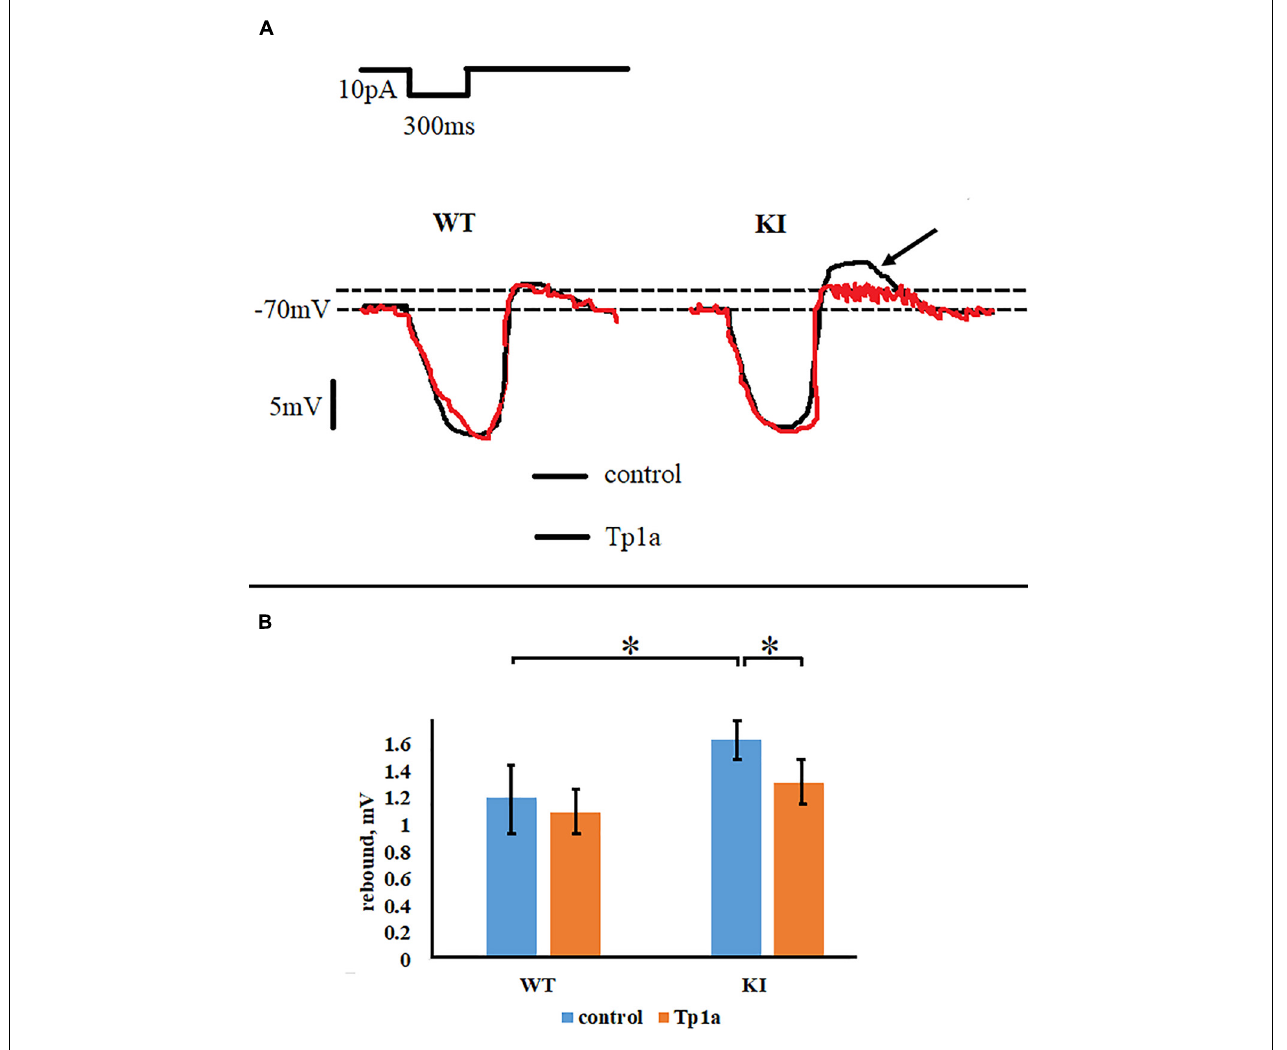
FIGURE 6 | Tp1a reduces rebound effect after a 300-ms hyperpolarizing pulse of 10 pA in R192Q KI TG neurons. (A) Representative responses of WT and R192Q KI neurons, recorded in control and after application of Tp1a (7 nM, 30 min). Arrow shows higher rebound in KI which is reduced by Tp1a. (B) Histograms represent rebound effect in WT and KI neurons under control conditions and after 30 min application of 7 nM Tp1a. *Indicates statistically significant change (two-sample Student’s t -test, p -values are given in the text body). Number of cells in each group: n = 90 (WT, control), n = 86 (WT, Tp1a), n = 109 (KI, control), n = 96 (KI, Tp1a). Note small but statistically significant difference between WT and KI neurons, and a reduction of the rebound effect in KI after Tp1a